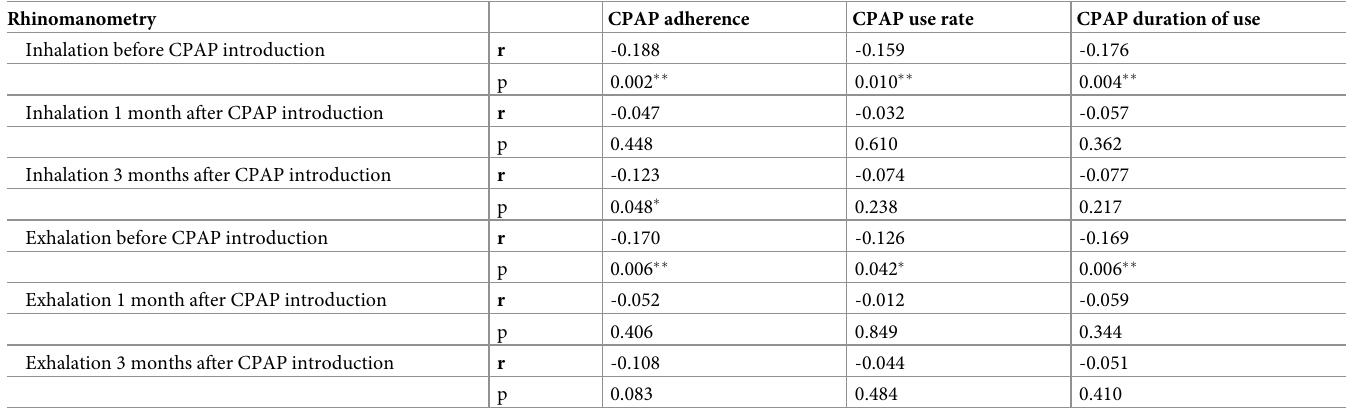
Table 3. Correlation between rhinomanometry and CPAP adherence at enrollment.